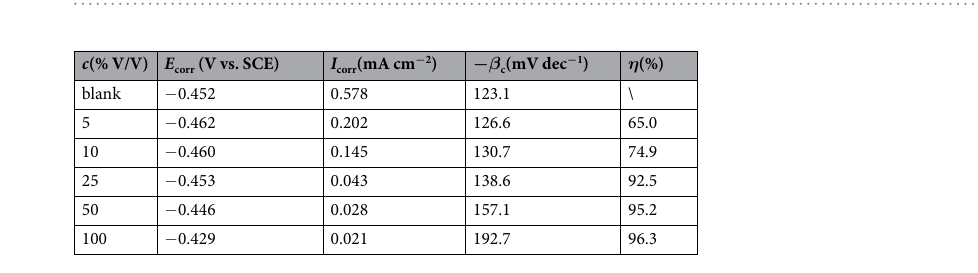
Figure 2. Potentiodynamic polarization curves of mild steel in 0.5 M H 2 SO 4 solutions without and with different V/V concentrations of LLE at 298 K.